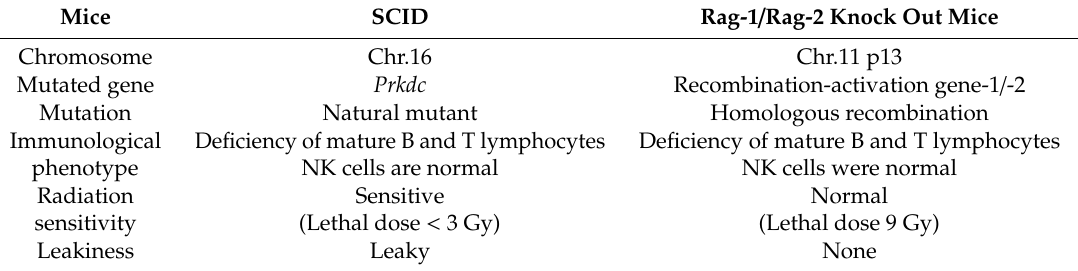
Table 2. Comparison of SCID and Rag ‐ 1/Rag ‐ 2 mutation.